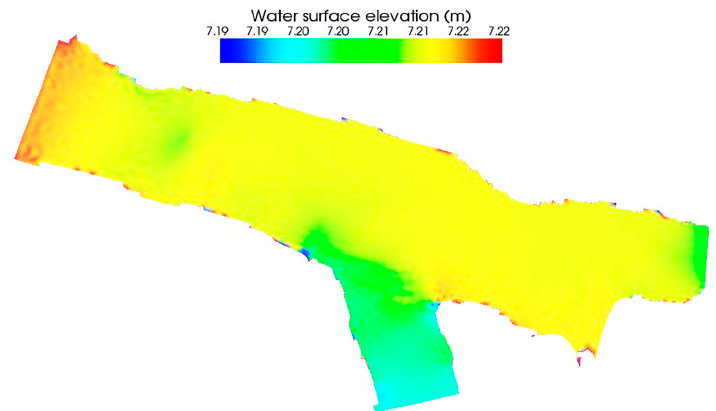
Figure 8. Simulation of water surface elevation of the Tigris branching junction.